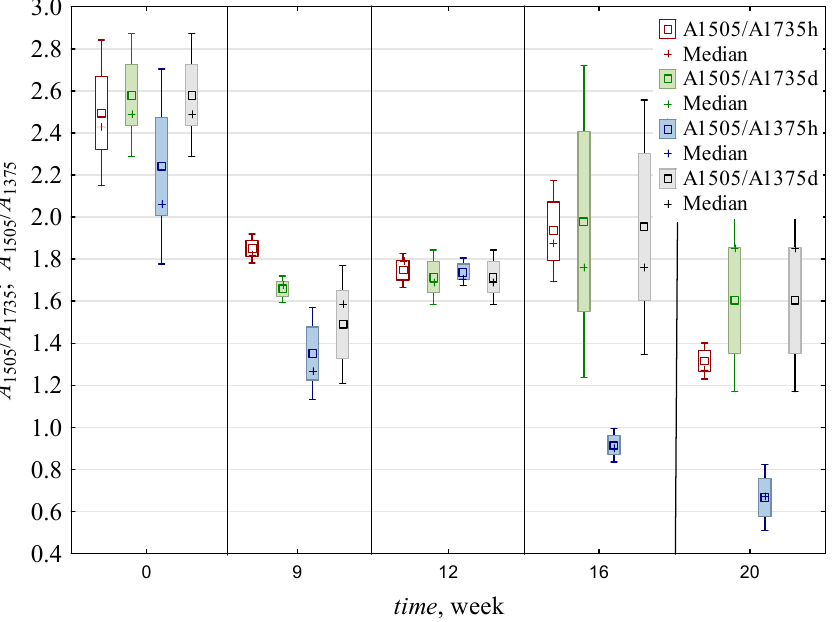
Figure 4. Values of ratios of absorbances for respective wavenumbers: A 1505 / A 1735 and A 1505 / A 1375 ; h —peak height, d —peak deconvolution, □ —mean, frame— SE , and whisker— SD .